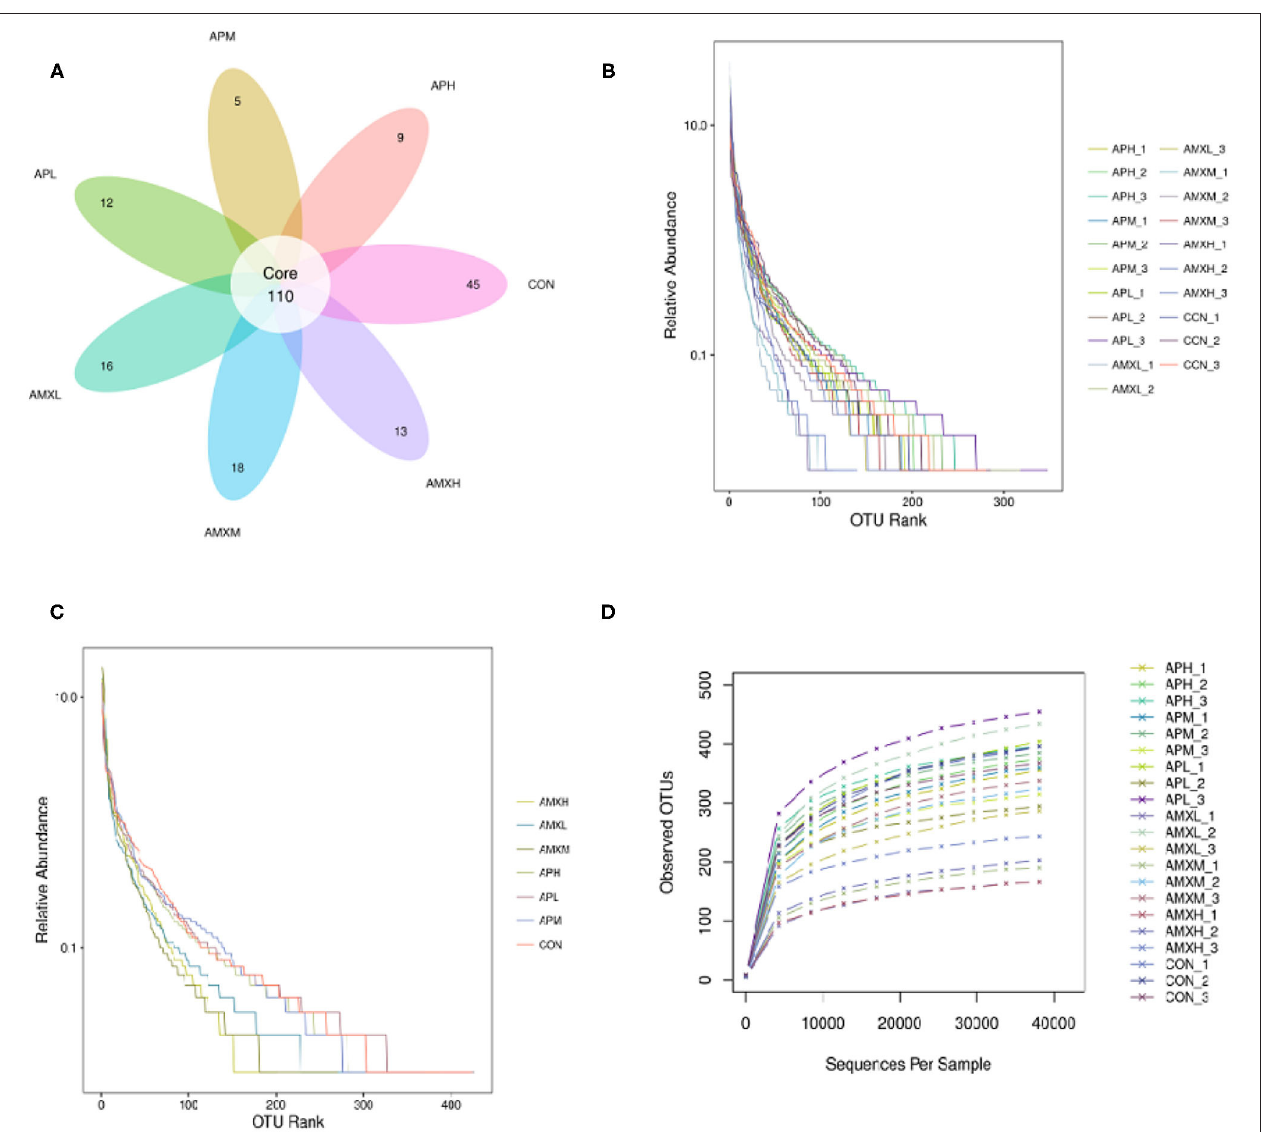
FIGURE 2 | Venn diagrams and feasibility analysis (A–D)